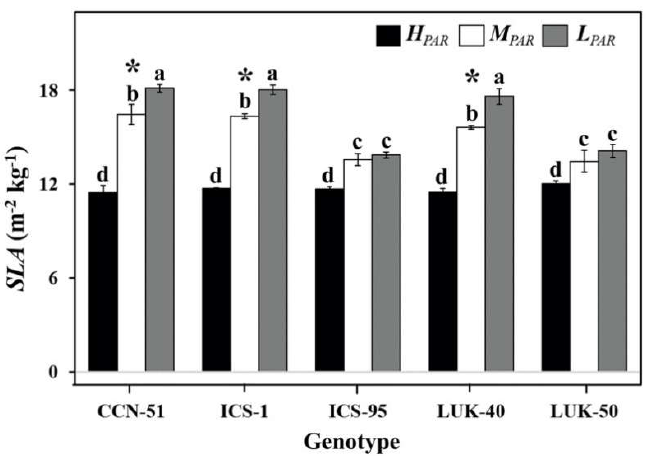
Figure 2. The specific leaf area (SLA; m 2 kg –1 ) for five genotypes of cacao in three levels of radiation considered were high mean daily incident photosynthetically active radiation (H PAR , 2100 ± 46 mol m − 2 s − 1 ) that was in full sun, medium mean daily incident photosynthetically active radiation (M PAR , 1150 ± 42 mol m − 2 s − 1 ) and low mean daily incident photosynthetically active radiation (L PAR , 636 ± 40 mol m − 2 s − 1 ). a,b,c : Values in bars with different letters indicate significant differences between gen- otypes of cacao × radiation level (post hoc LSD Fisher, p < 0.05). *: Means statistical differences be- tween radiation levels in each cocoa genotype. The results include means ± SE ( n = 54 leaf discs).